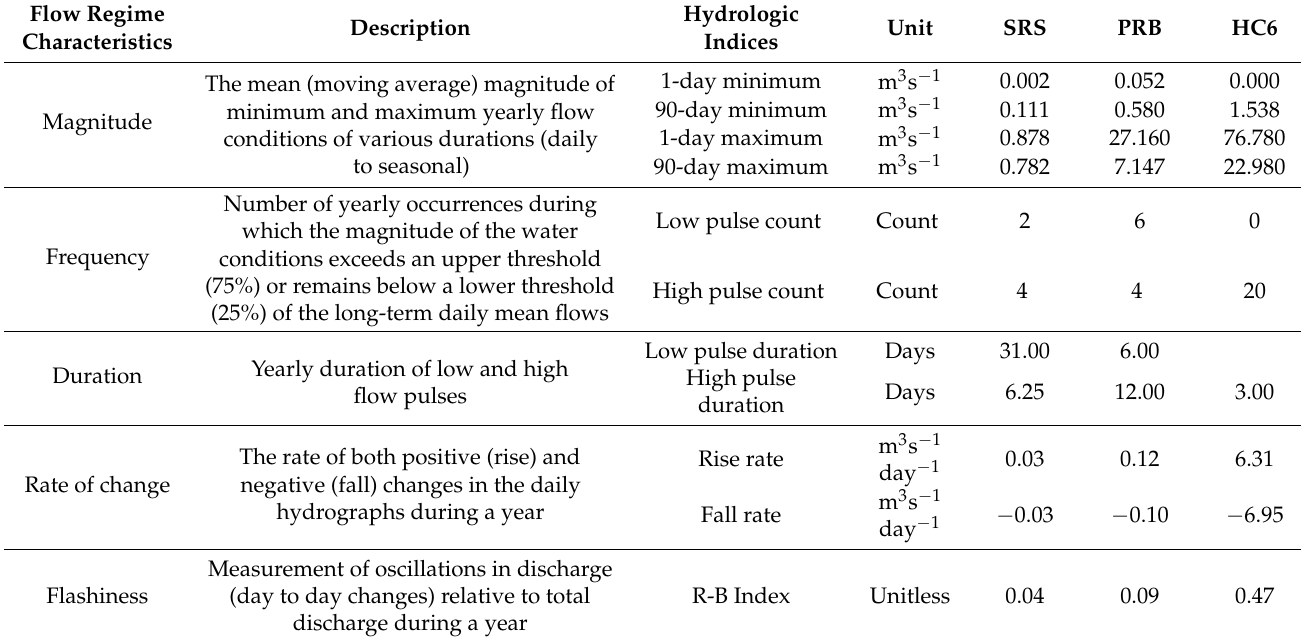
Table 2. Calculated Indicators of Hydrologic Alteration (IHA) [10,34] and Richards–Baker Flashiness Index (R-B Index) [35] for SRS (slough), PRB (river), and HC6 (canal) for the years 2004 to 2018. Flow Regime